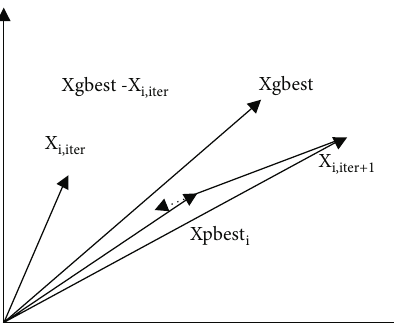
Figure 5: Schematic diagram of individual 2D update.